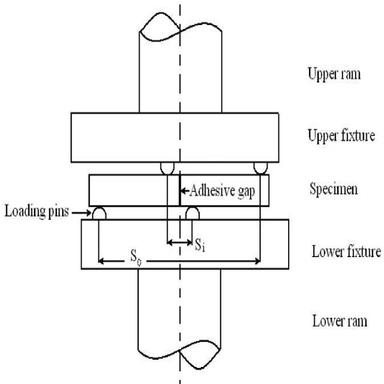
Schematic scheme of test fixture, which Si = 4.0mm and S0 = 30.0mm in this work.